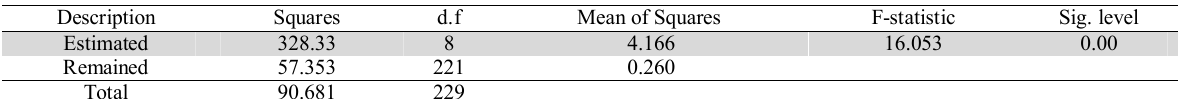
Fisher's Test Results